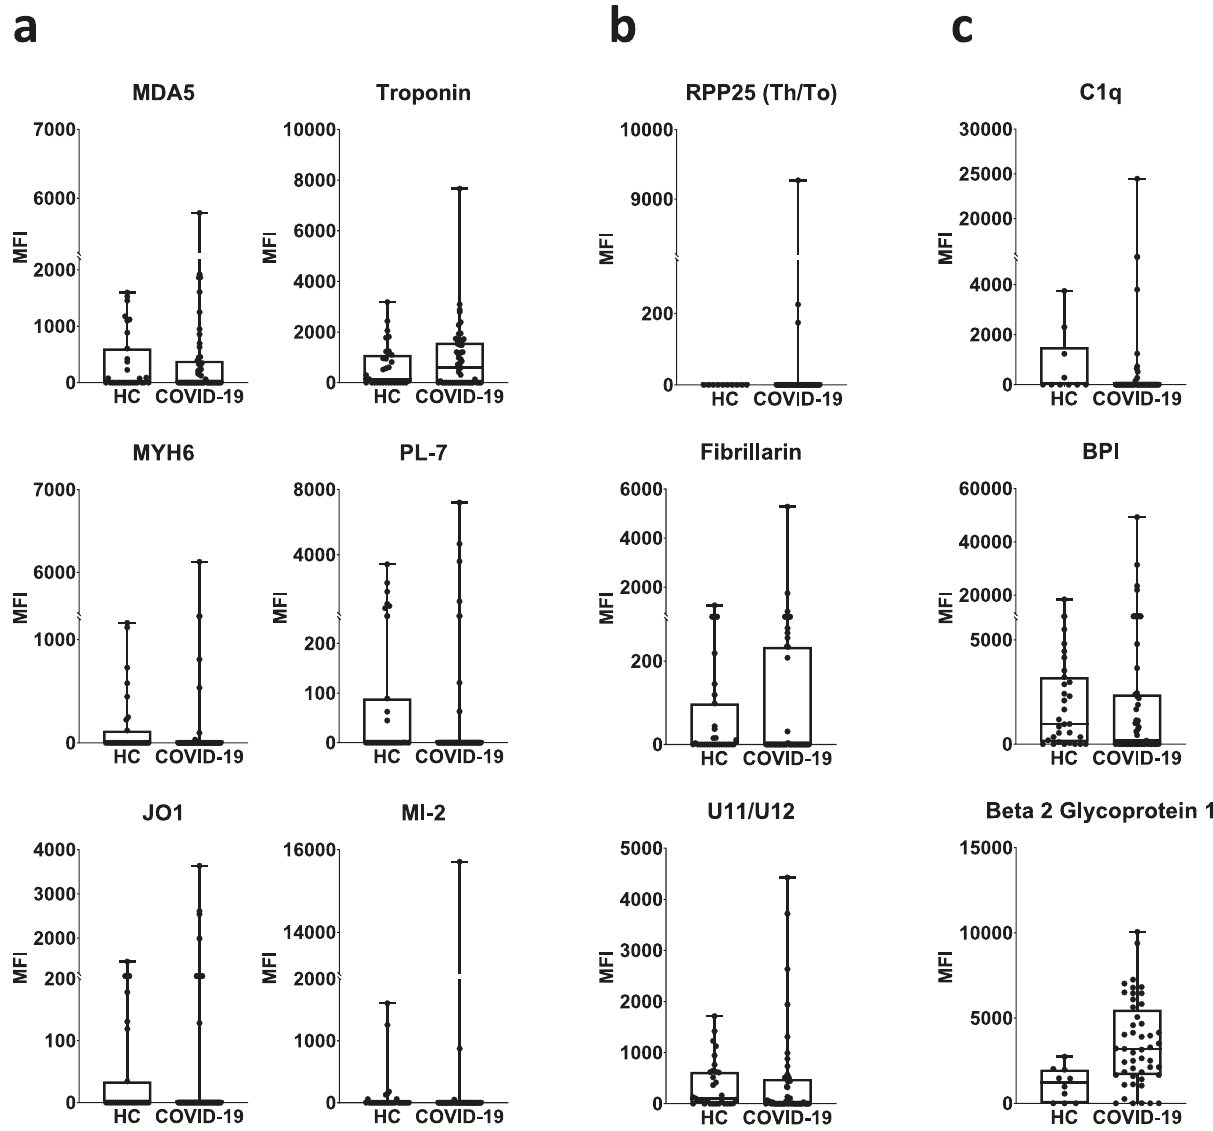
Fig. 2 Serum autoantibodies in COVID-19 patients recognize antigens targeted in rare connective tissue diseases, and antigens associated with pathogenicity. Boxplots of twelve antigens corresponding to Fig. 1. a Antigens associated with autoimmune myositis and myocarditis (MDA5, troponin 1, MYH6 (alpha-myosin), PL-7, Jo-1, and Mi-2). b RNA-containing antigens associated with systemic sclerosis (RPP25 Th/To, Fibrillarin, and U11/U12). c Antigens that may be pathogenic (C1q and β 2GP1) and associated with vasculitis (BPI). MFI data in a – c are represented as boxplots where the middle line is the median, the lower and upper hinges correspond to the fi rst and third quartiles, the upper whisker extends from the hinge to the largest value, and the lower whisker extends from the hinge to the smallest value. Individual MFI values are displayed as dots. MFI is shown on the y -axis. Subjects are shown on the x -axis ( n = 51 unpaired UPenn and Marburg COVID-19 patients and n = 31 HC). Source data are provided as a Source Data fi